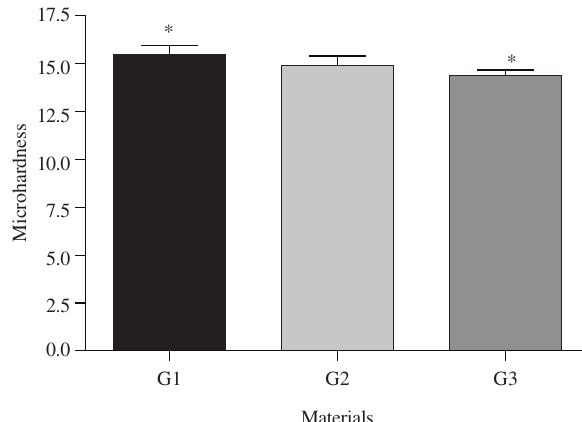
Figure 3. Mean values and standard deviation of Vickers microhardness (MHV) of the materials studied. (*) Significant